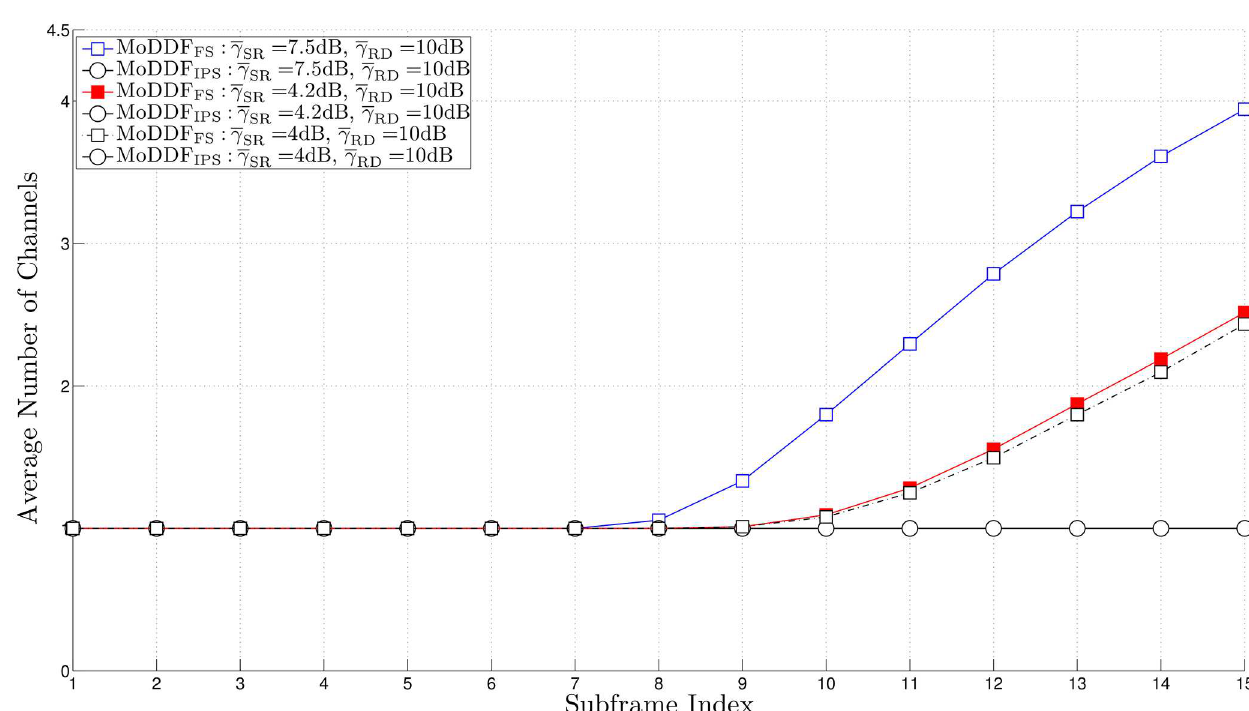
¼ 2 dB, and R th = 20. SD